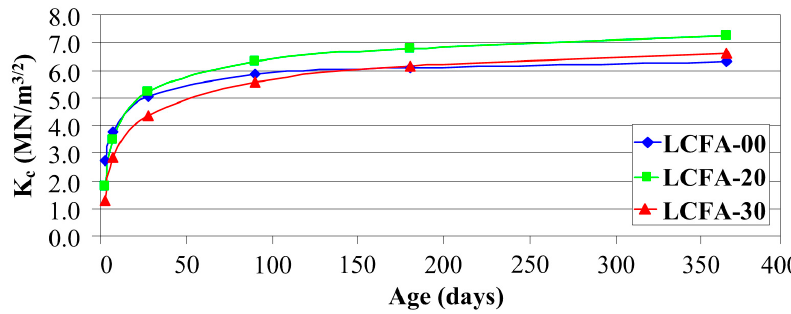
Figure 14. Generalized fracture toughness of analyzed concretes as a function of curing time.